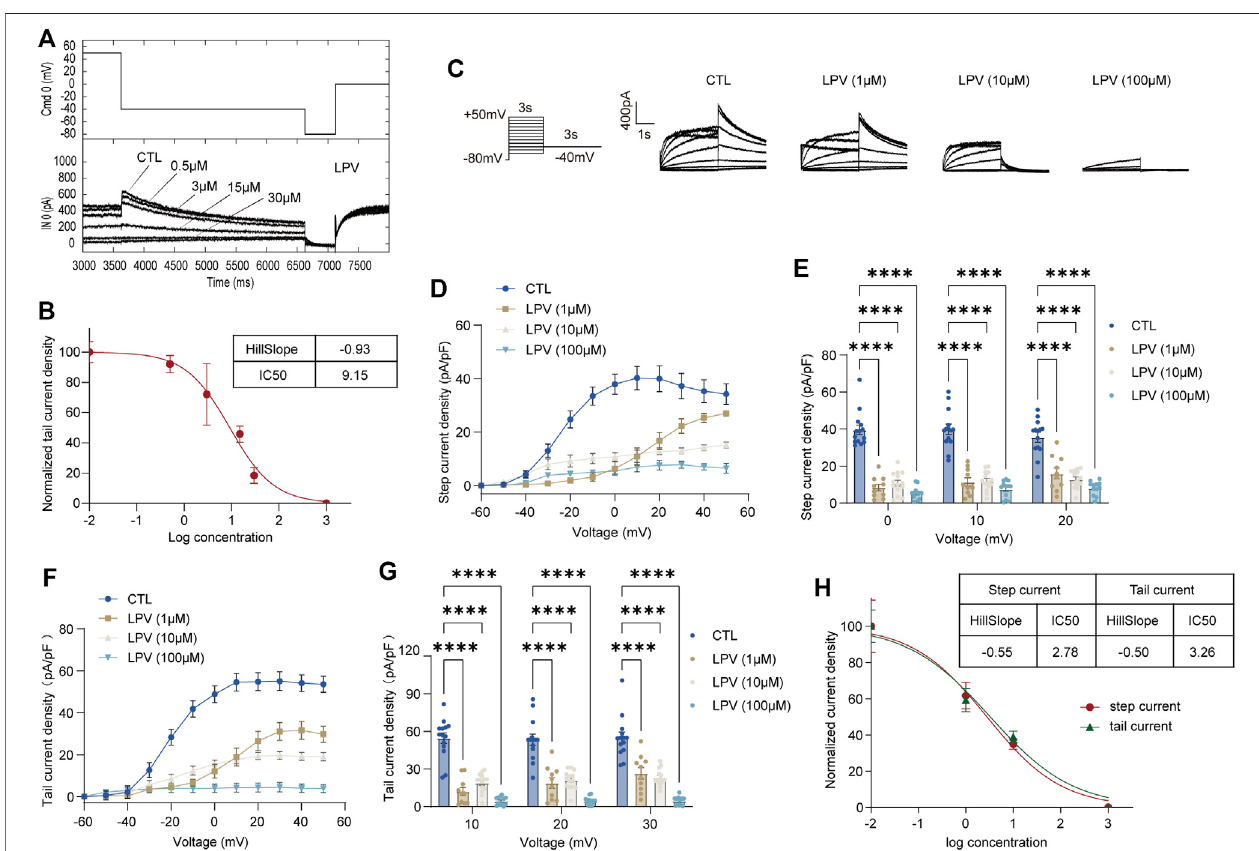
FIGURE2 | Inhibitionof the hERG currents bylopinavir(LPV). (A) Concentration-dependent acute inhibition ofhERG tail currents elicited by the protocol is shown. (B) Normalizeddataoftailcurrentdensityat+50 mVwere fi ttedwiththeHillequationtoyieldaconcentrationforhalf-maximalinhibition(IC50)andaHillcoef fi cient, n =5. (C) Whole-cell patch-clamp for representative I hERG recorded in control (CTL) and after LPV (1 – 100 μ M) for 24 h of treatment recorded by the voltage protocol. (D) Original data using the membrane capacitance (pF) of each cell to calculate the step current density (pA/pF) to form the I – V curve of the hERG channel. (E) Correspondingbarchartshowsthestatisticalstepcurrentat0 mVto+20 mV. (F) I – Vcurveoftailcurrentdensity(pA/pF). (G) Statisticaltailcurrentdensityat+10 mVto + 30 mV; n = 12 – 16. **** p < 0.0001. (H) Data on step and tail current density at +30mV were fi tted with the Hill equation yielding an IC50 and a Hill coef fi cient.